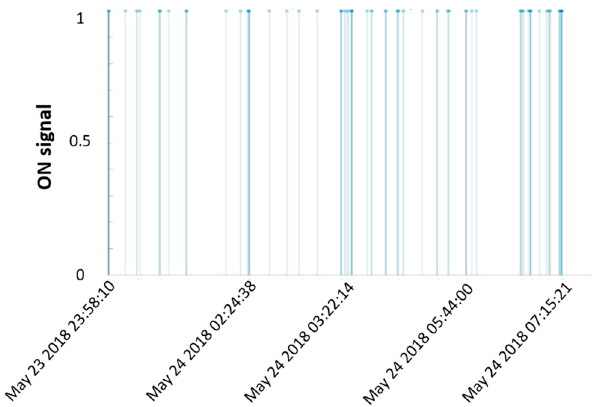
Figure 2. PIR sensor: one night example of data collection; the PIR sensor “ON” is displayed. On the x-axis, the timestamps refer to each night movement detection (not all the PIR date events are displayed to make the figure readable).